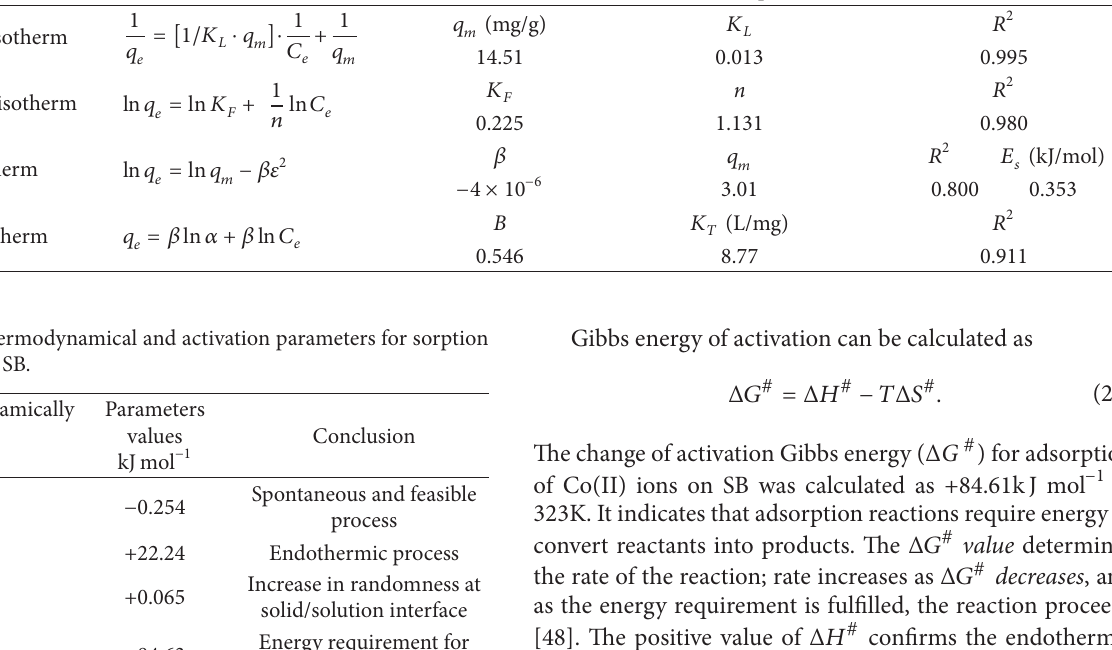
T 3: Equilibrium isotherm parameters of biosorption of Co(II) on SB. Adsorption isotherm Linear form Constant parameters